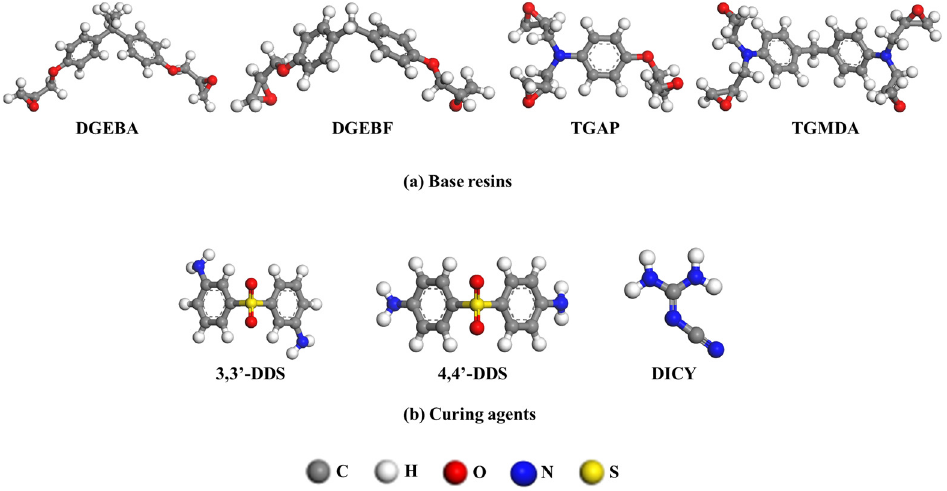
Figure 1. Molecular structures of ( a ) base resins (DGEBA, DGEBF, TGAP, TGMDA) and ( b ) curing agents (33DDS, 44DDS, DICY) that compose epoxy resin systems.